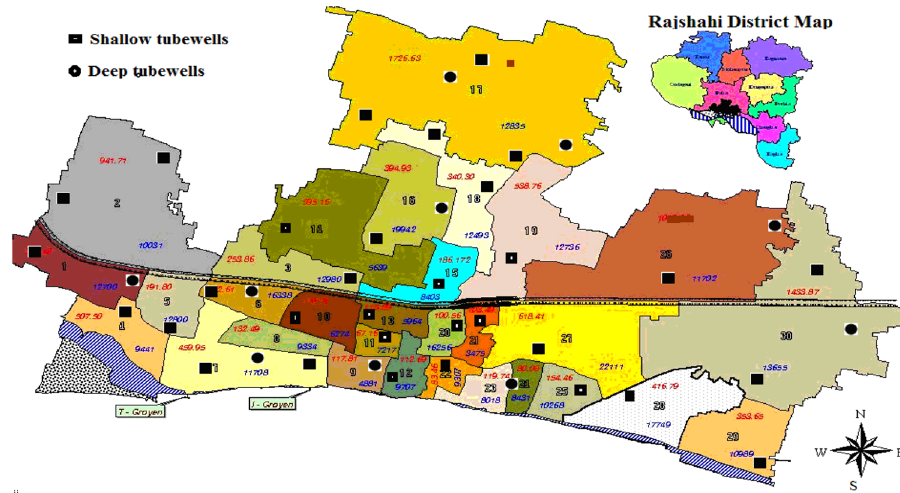
Fig. 1 Map of Locations of